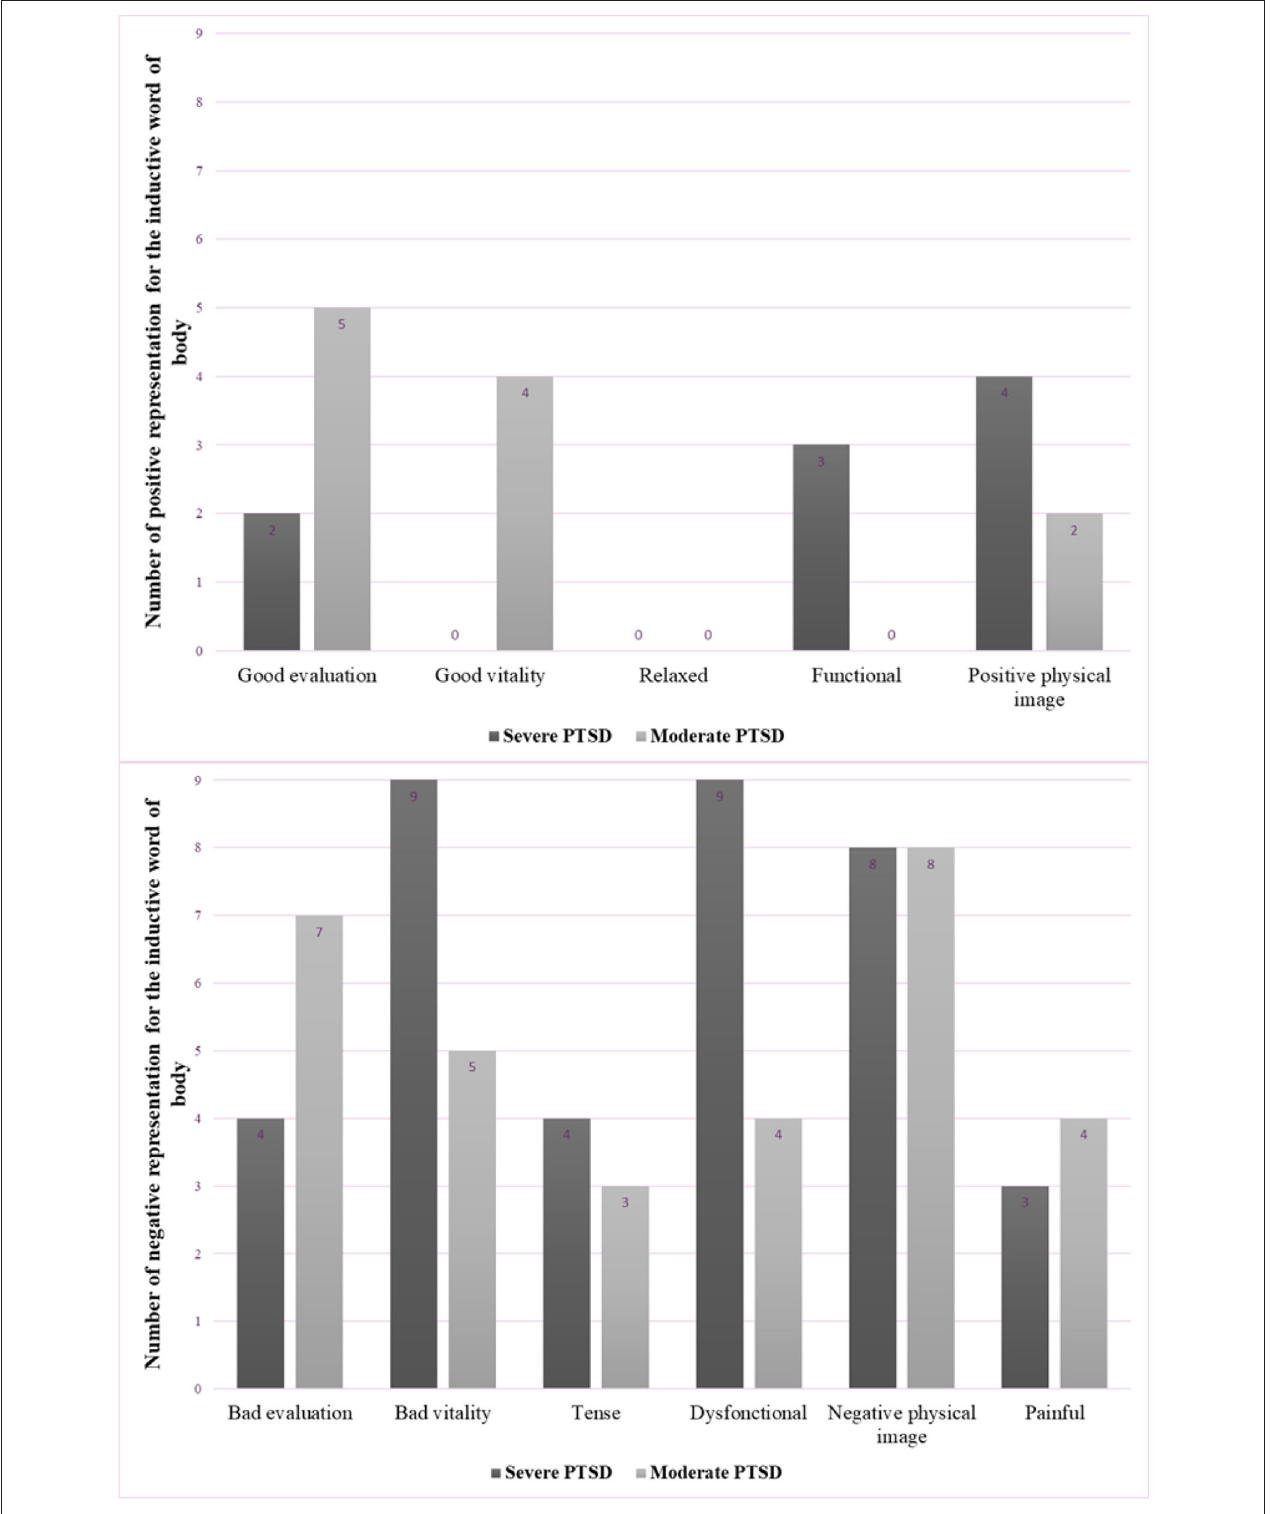
FIGURE 2 | Categories and numbers of positive (top) and negative (bottom) words referring to the physical body, for severe and moderate PTSD groups.